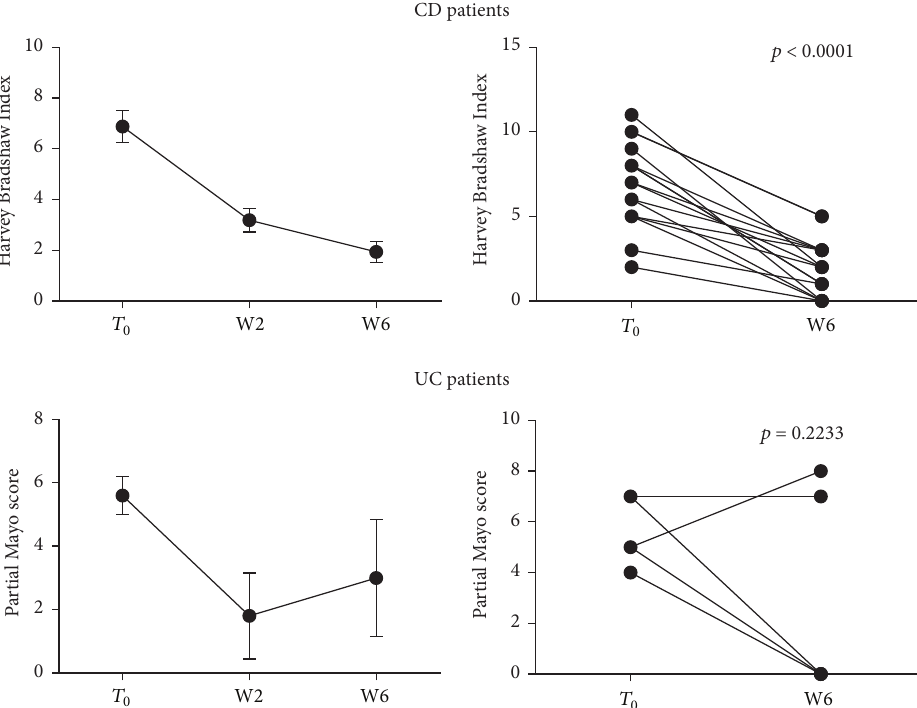
Figure 1: Clinical activity indexes throughout anti-TNF therapy. Harvey-Bradshaw Index and partial Mayo score were calculated before each drug administration to CD ( 𝑁 = 16 ) and UC ( 𝑁 = 5 ) patients, respectively, undergoing anti-TNF therapy. Statistical analysis was performed using Student’s 𝑡 -test for paired data. Data are presented as single data point or as mean ± SEM.